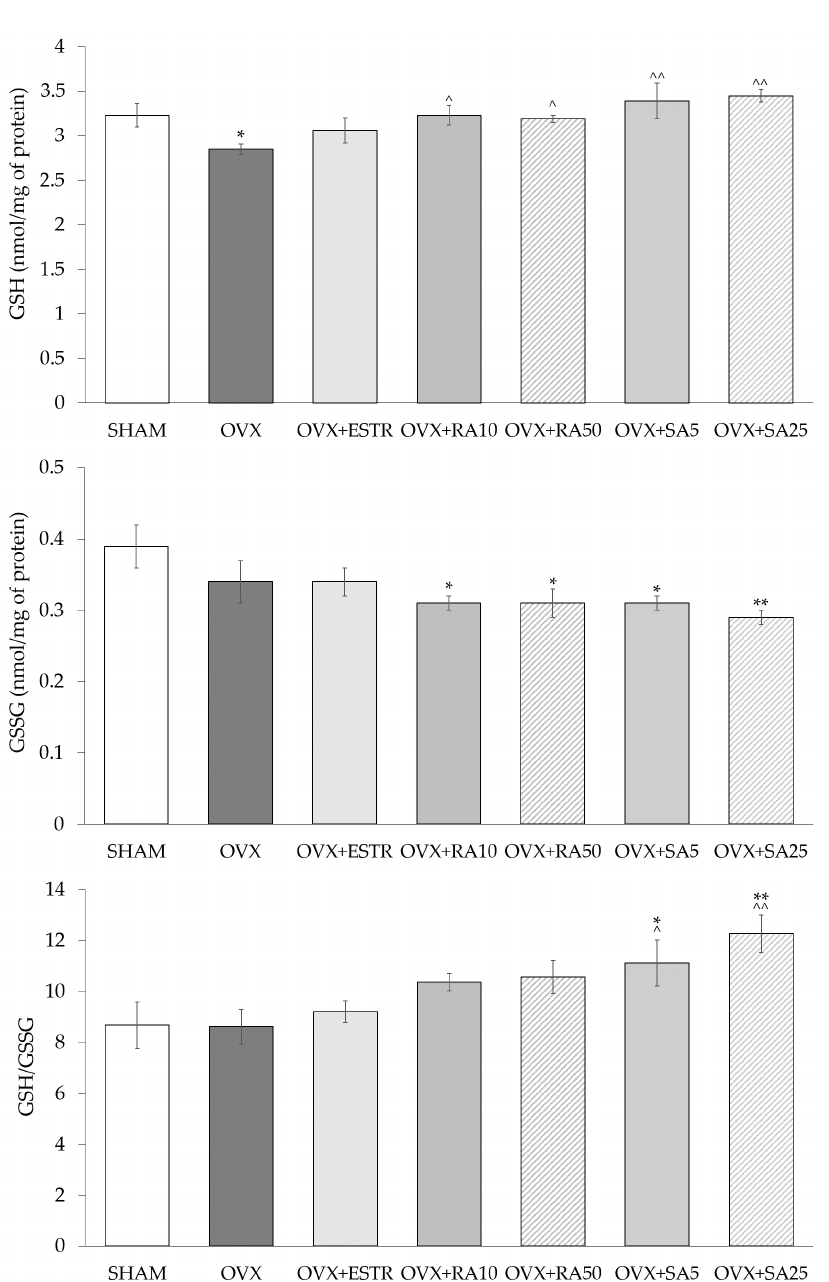
Figure 2. Effect of rosmarinic acid and sinapic acid on the GSH and GSSG content and on the GSH/GSSG ratio in the lenses of ovariectomized rats. Rosmarinic acid at doses of 10 mg/kg (OVX + RA10) and 50 mg/kg (OVX + RA50), sinapic acid at doses of 5 mg/kg (OVX + SA5) and 25 mg/kg (OVX + SA25) or estradiol at a dose 0.2 mg/kg (OVX+ESTR) were administered orally to ovariectomized rats, once daily for 28 days. SHAM: sham-operated control rats; OVX: ovariectomized control rats; GSH: reduced glutathione; GSSG: oxidized glutathione. Results are presented as the mean ± SEM. One-way ANOVA followed by Duncan’s test were used for evaluation of the significance of the results. * p ≤ 0.05, ** p < 0.01: significant differences with regard to the SHAM control rats. ^ p ≤ 0.05, ^^ p < 0.01: significant differences with regard to the OVX control rats.